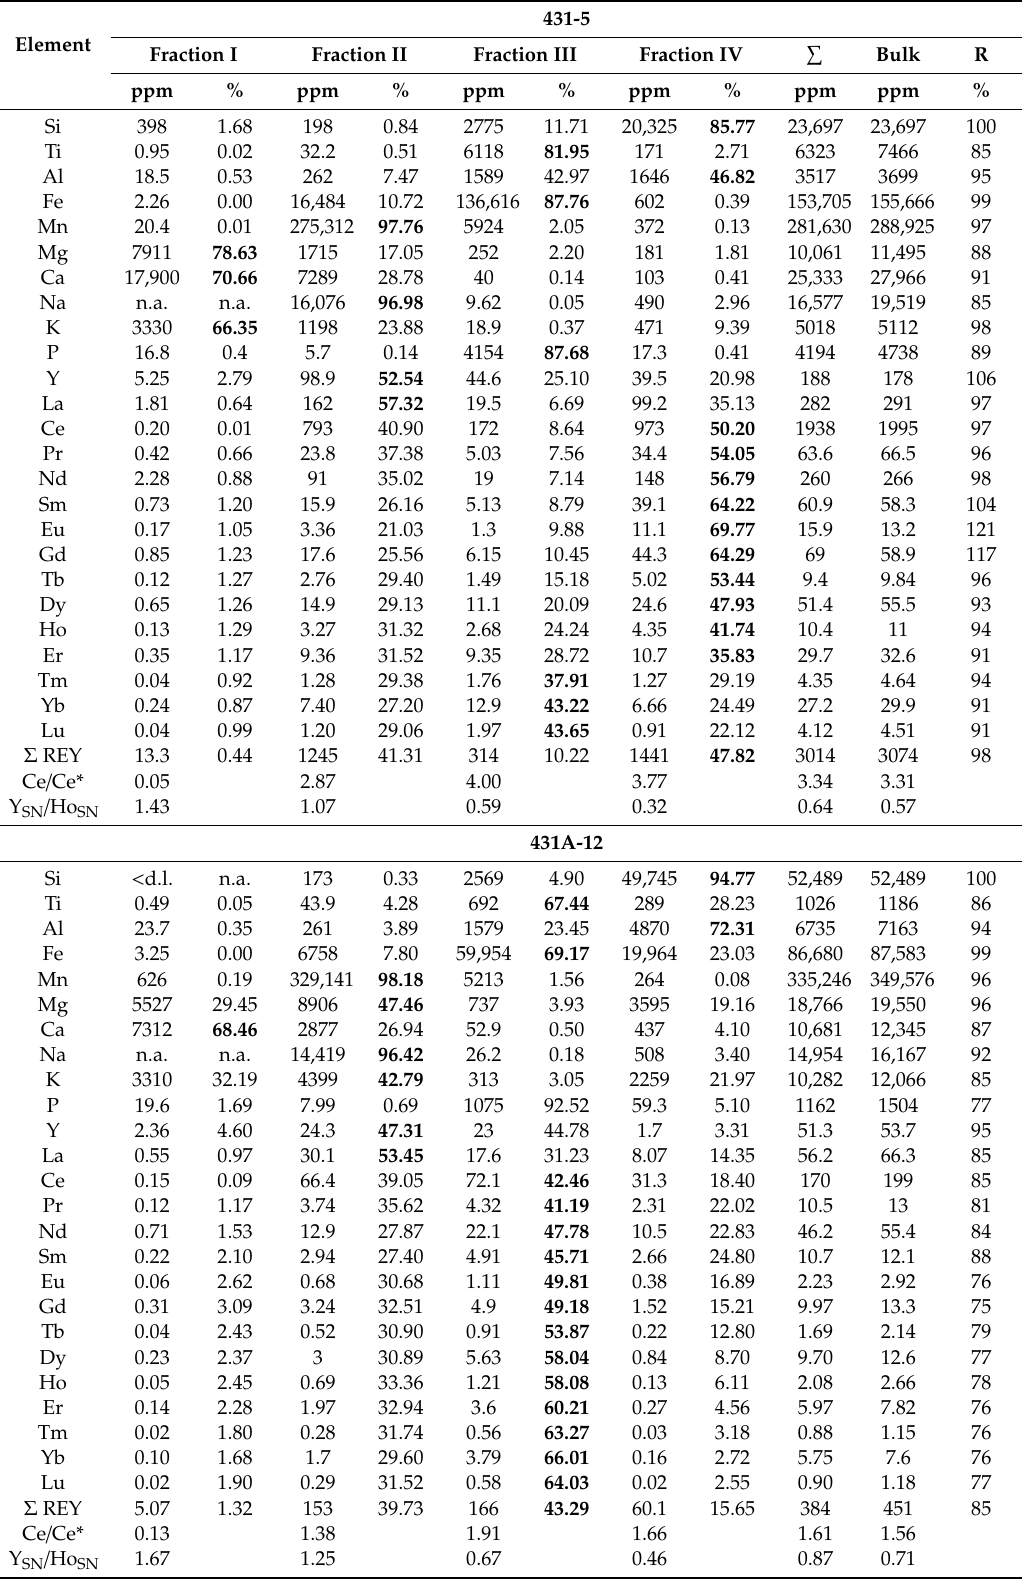
Table 4. Concentration and percentage (%) of major elements and rare earth elements and yttrium (REY) (ppm) in 431 and 431A DSDP Holes Fe-Mn deposits as well as recovery elements (R) during leaching